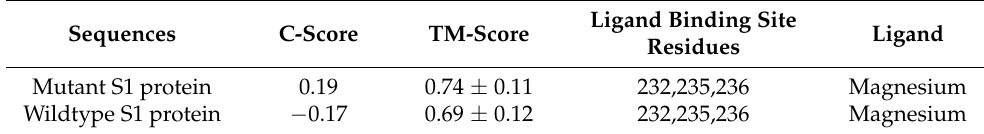
Figure 5. Homology modeling predicted by I-TASSER. 3D structures of S1 protein of wildtype (blue) and mutant (yellow) are shown. Table 1. TM- and C-scores, and predicted aa residues bound to exogenous ligand (magnesium).